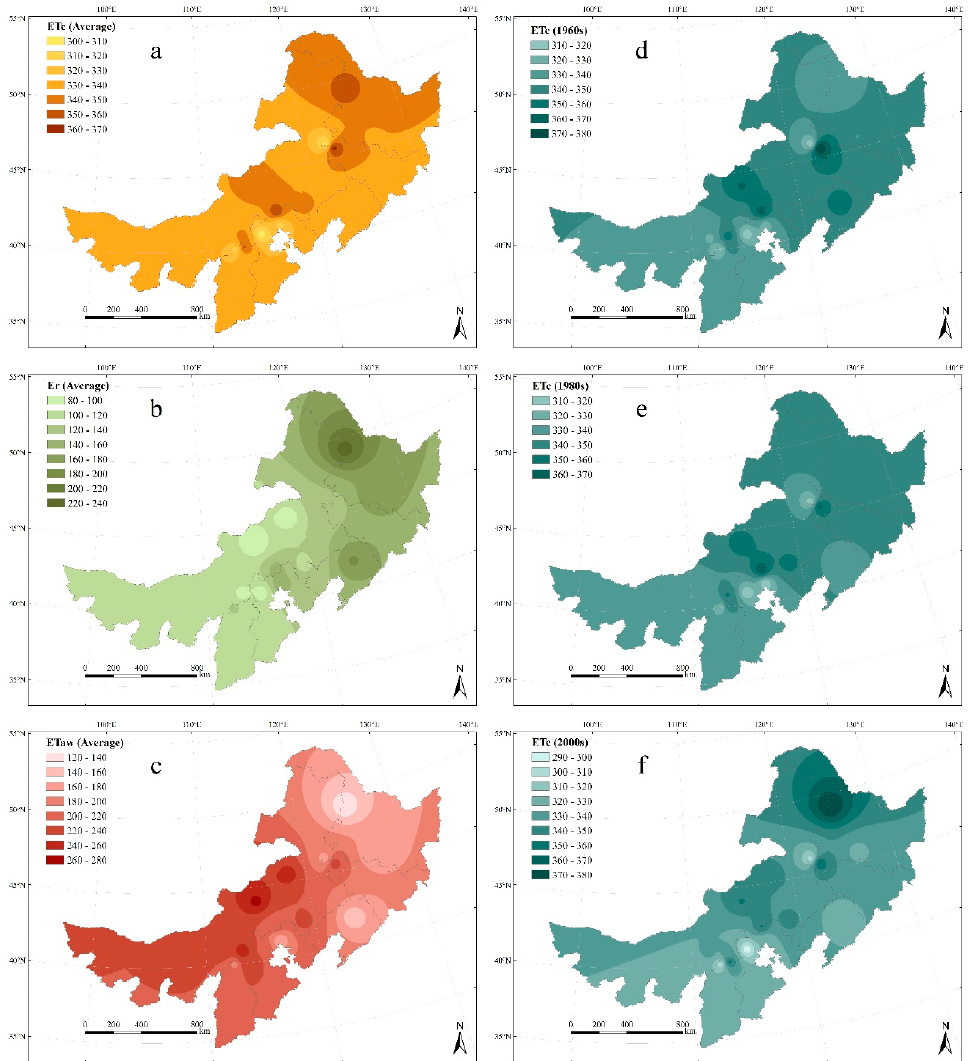
Figure 3. Spatial variation in oat water requirements (mm) (( a ): water requirement; ( b ): effective rainfall; ( c ): irrigation demand) during the past five decades (( d ): the 1960s; ( e ): the 1980s; ( f ): the 2000s) in North and Northeast China.